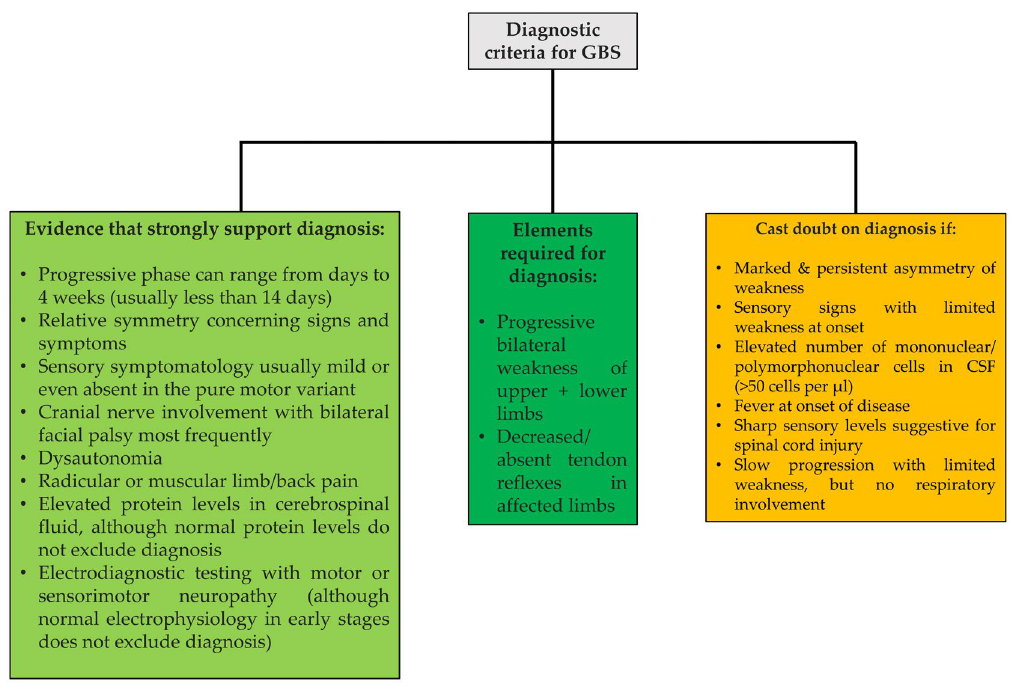
Figure 1. GBS diagnostic criteria [2].